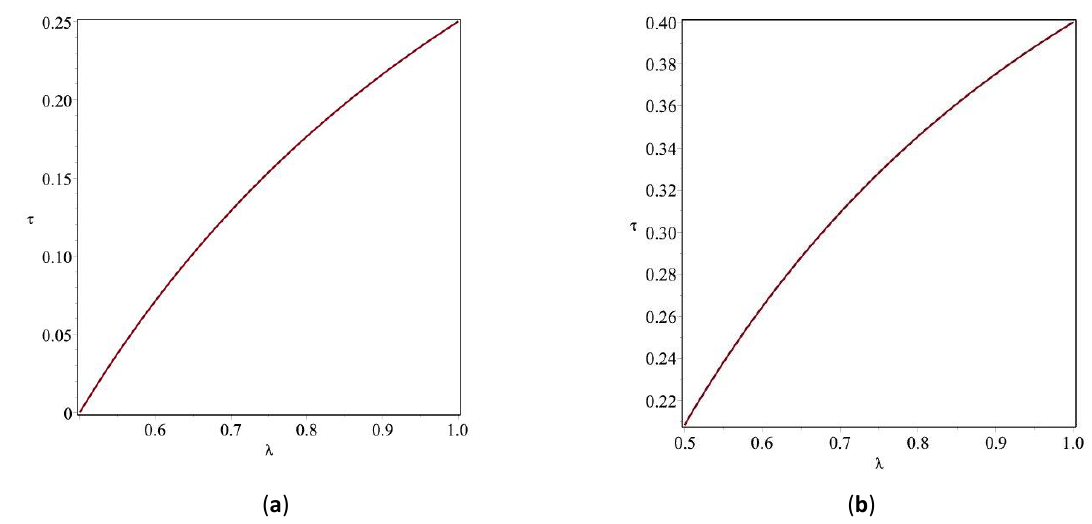
Figure 1. Effect of segregation on the ideal tax rate in community 1. Parameters: θ L = 1, θ H = 1 . 5 and π = 0 . 6, (A): a ( k ¯ − k i ) = 0, (B): a ( k ¯ − k i ) =